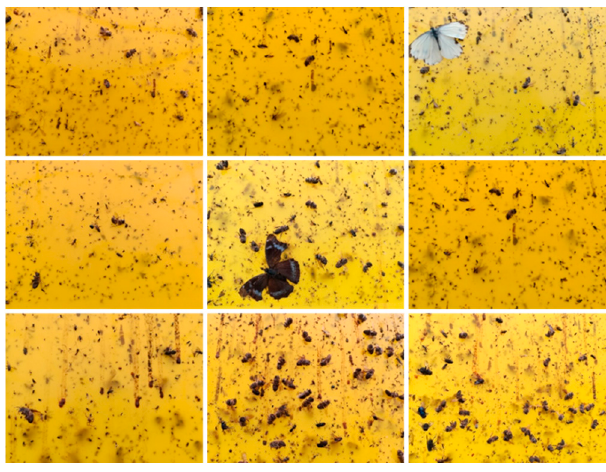
Figure 14. Nine test instances.